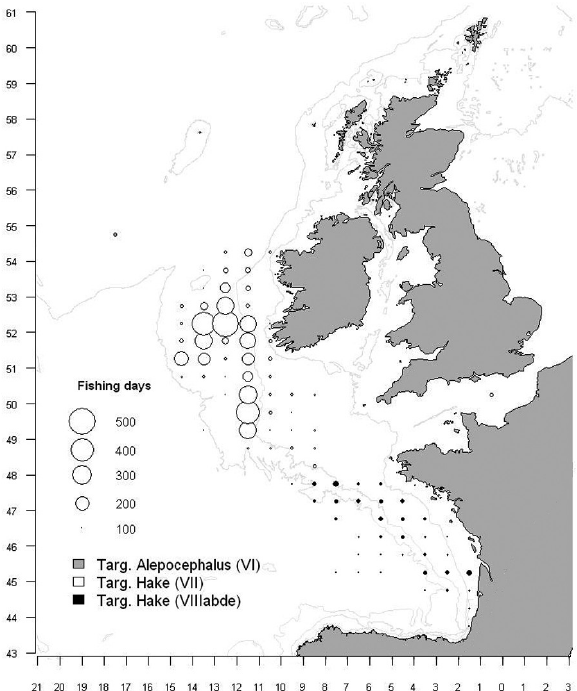
Fig . 3. – Spatial distribution of effort (fishing days) by deep fishing tactic from otter trawl in ICES Divisions VI, VII and